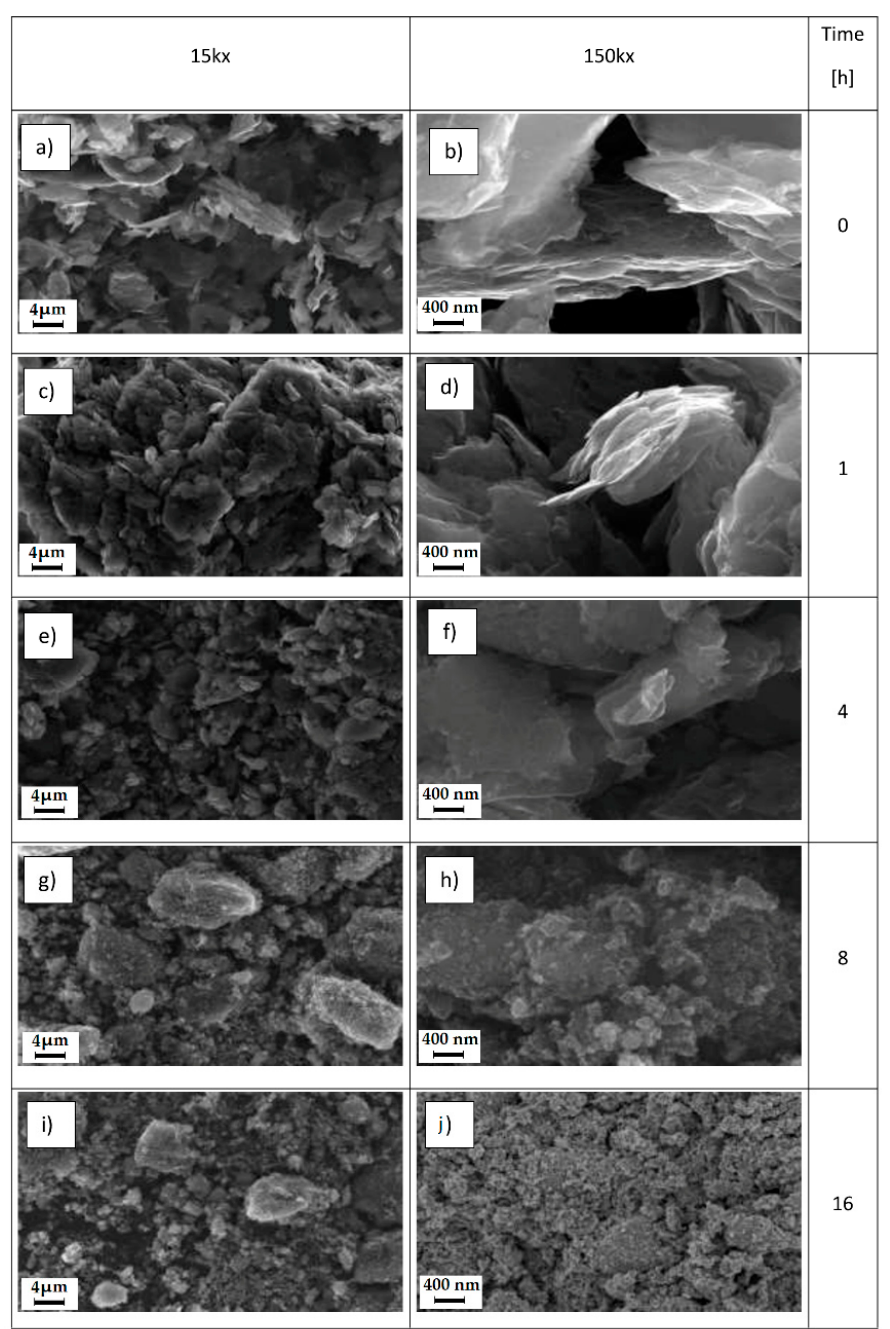
Figure 3. SEM images of graphite at magnifications of 15 and 150 Kx at different ball milling times: ( a , b ) 0 h; ( c , d ) 1 h; ( e , f ) 4 h; ( g , h ) 8 h; ( i , l ) 16